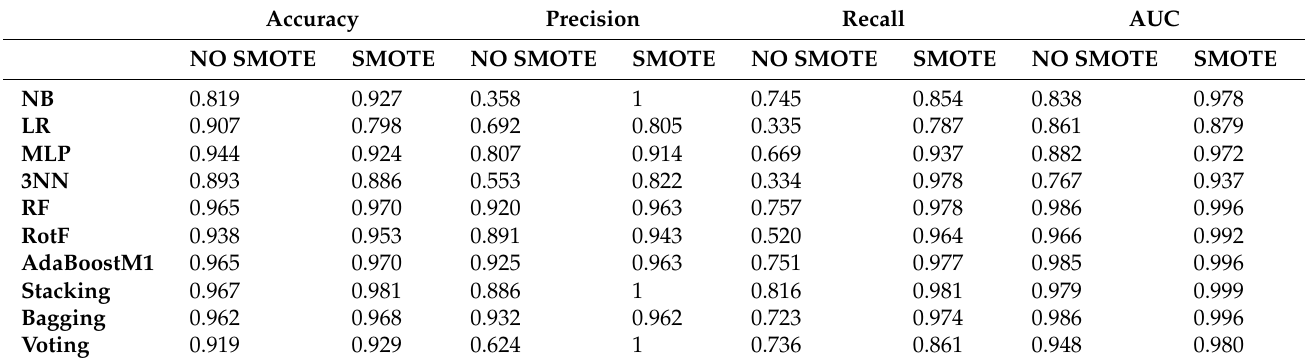
Table 4. Performance Evaluation before and after